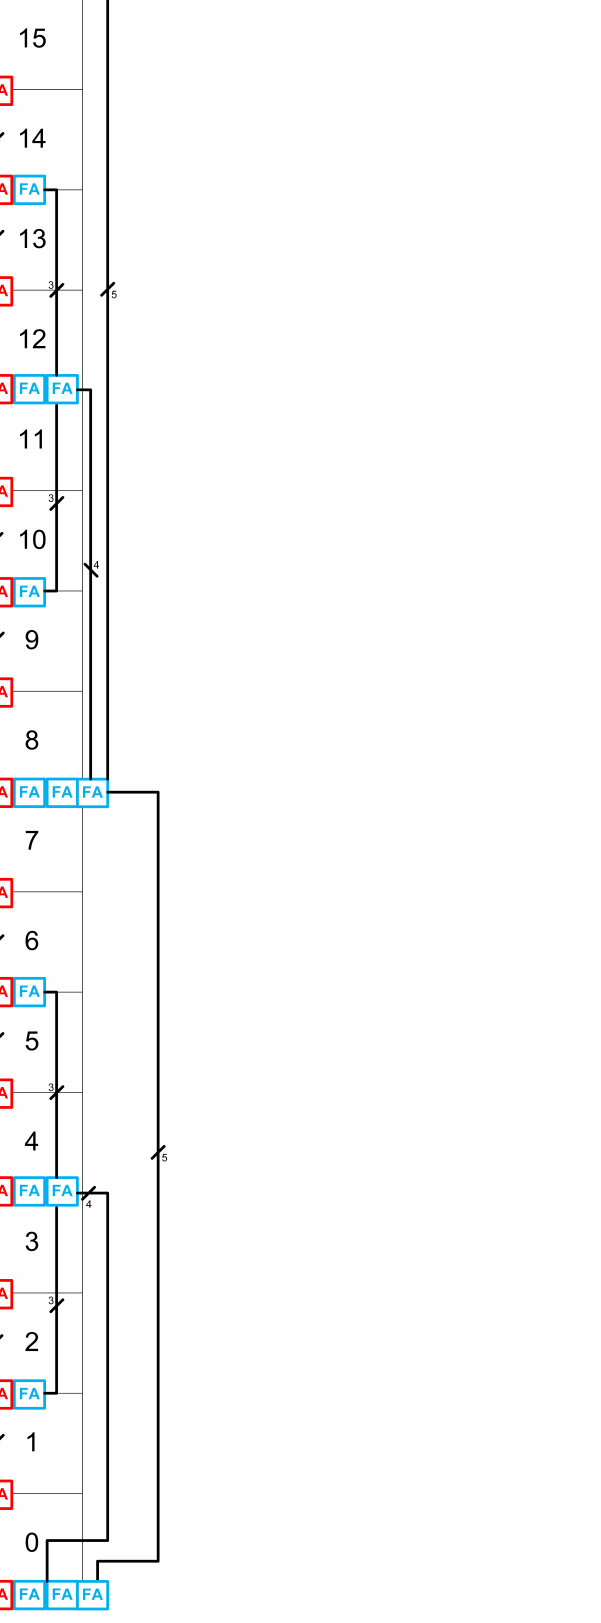
Figure 11. Diagram showing the 16-pixel summation scheme building block used to make a full